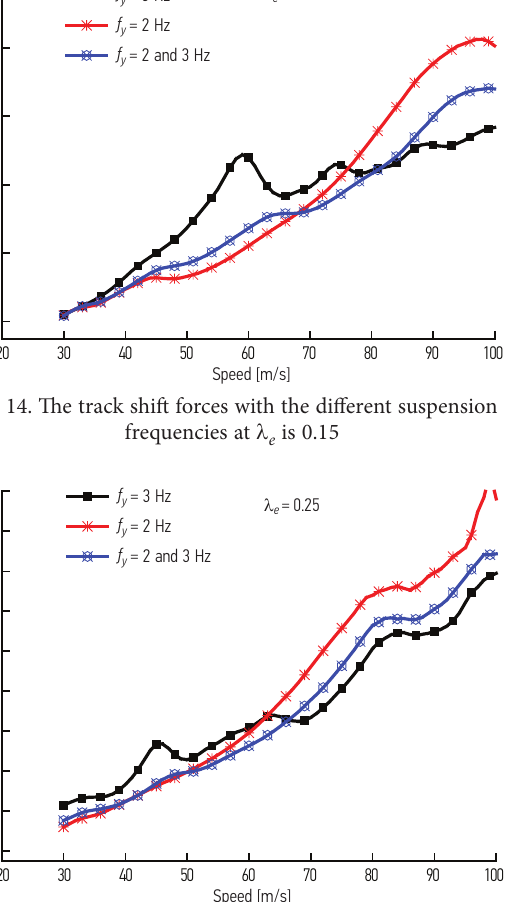
Fig. 15. The track shift forces with the different suspension frequencies at λ e is 0.25